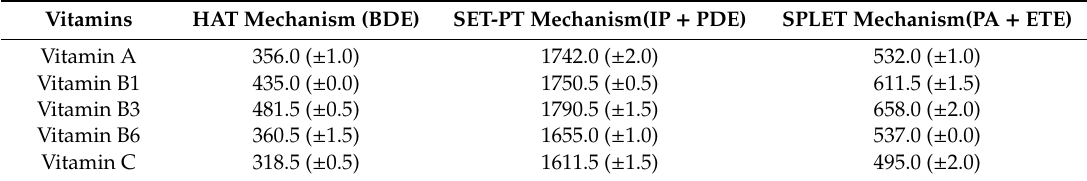
Table 1. Reaction enthalpies in kJ mol − 1 in water for the selected dietary vitamins, employing mean functional values of M05-2X and M06-2X.